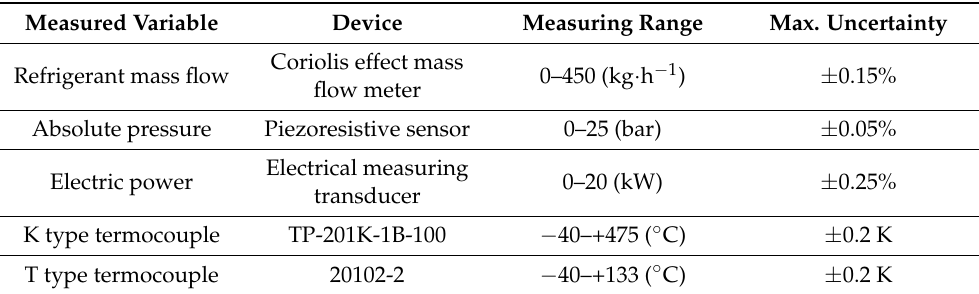
Table 2. The measuring device uncertainty.